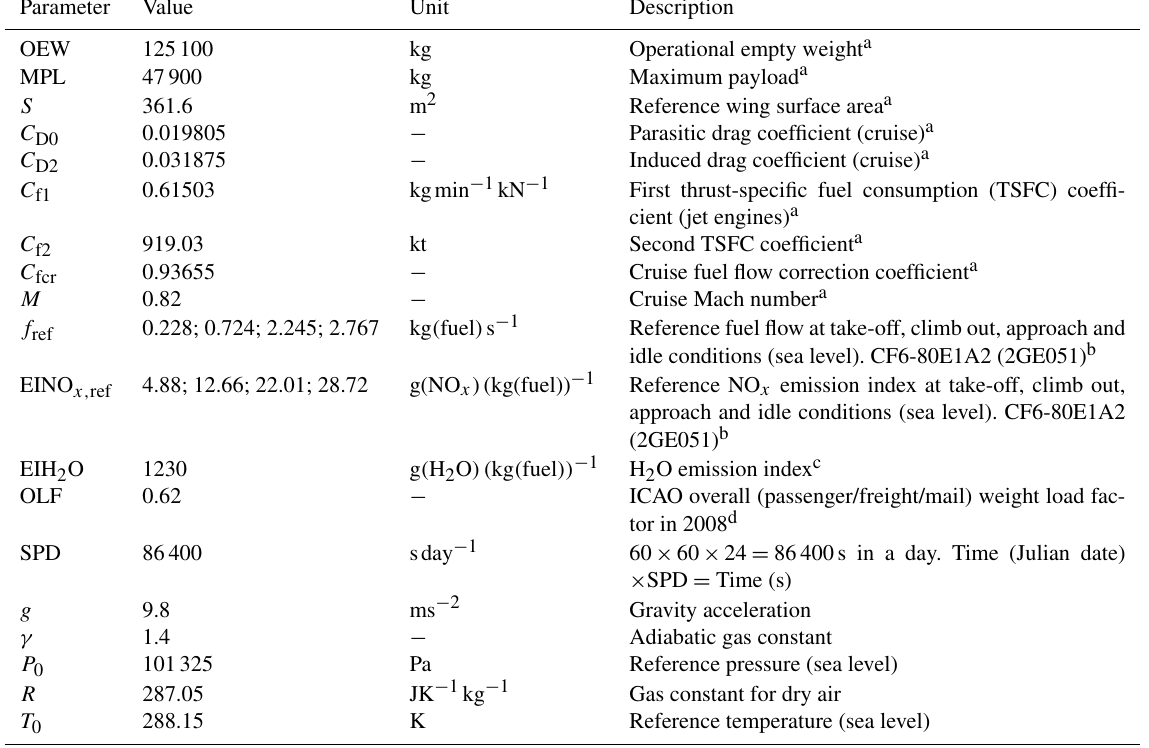
Table 1. Primary data of Airbus A330-301 aircraft and constant parameters used in AirTraf simulations.